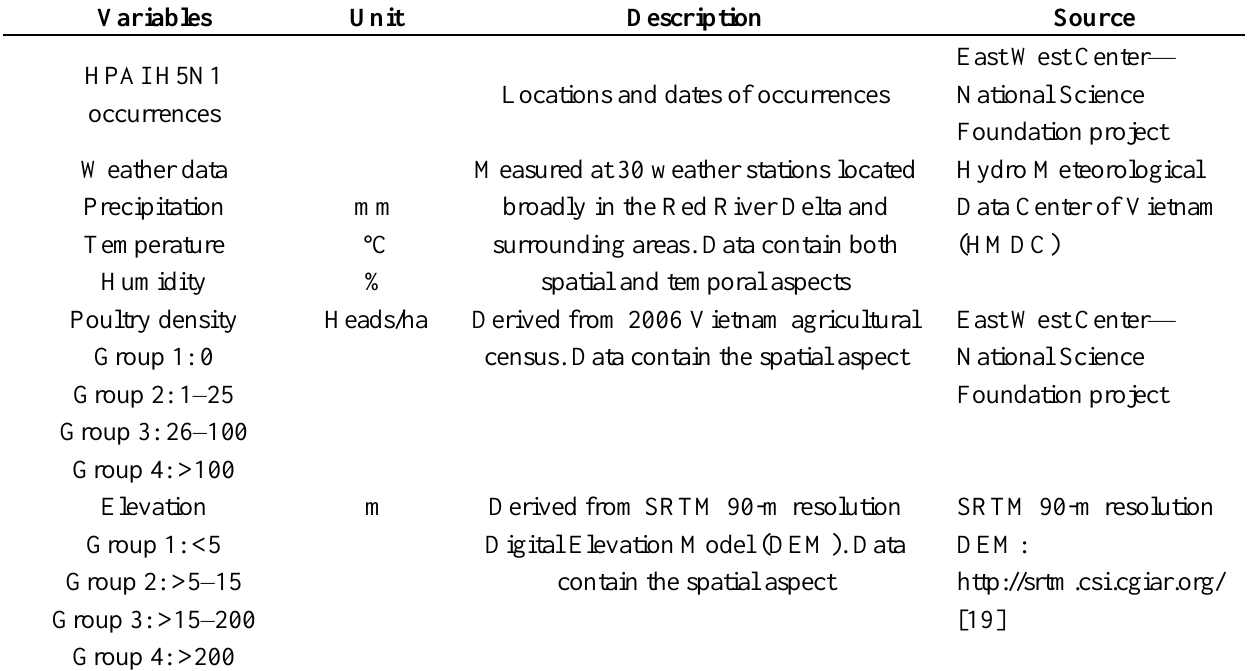
Table 1. Description and data sources of variables in the